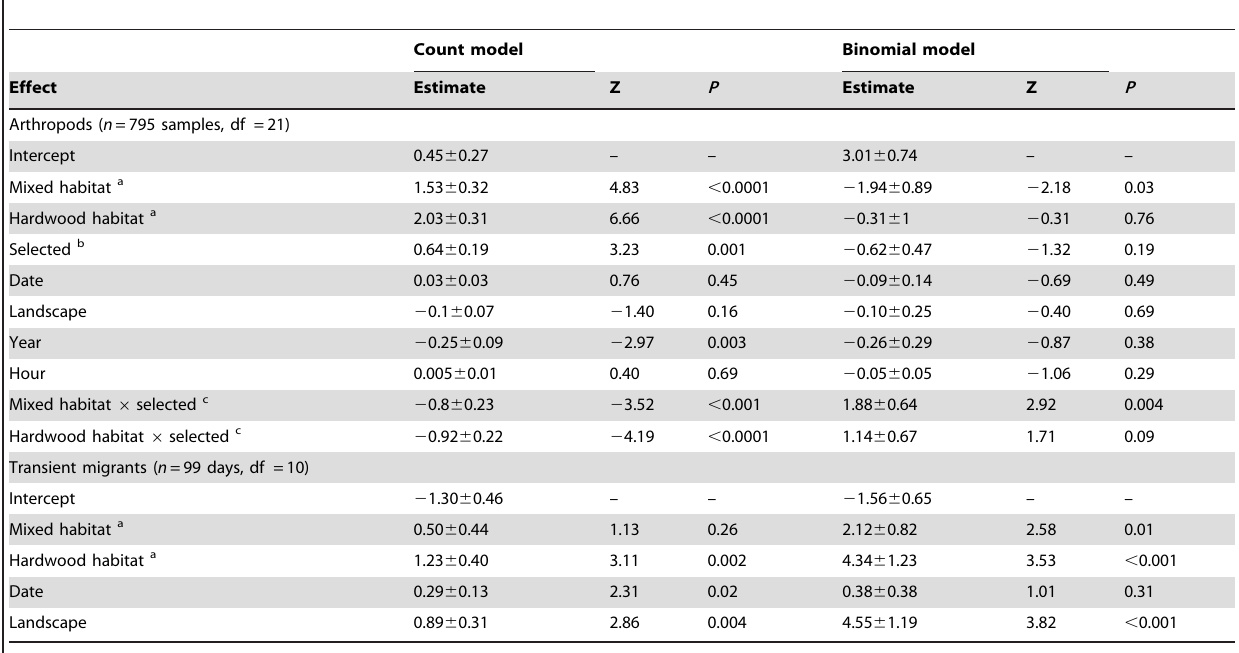
Table 2. Abundance and distribution of branch sampled arthropods and transient